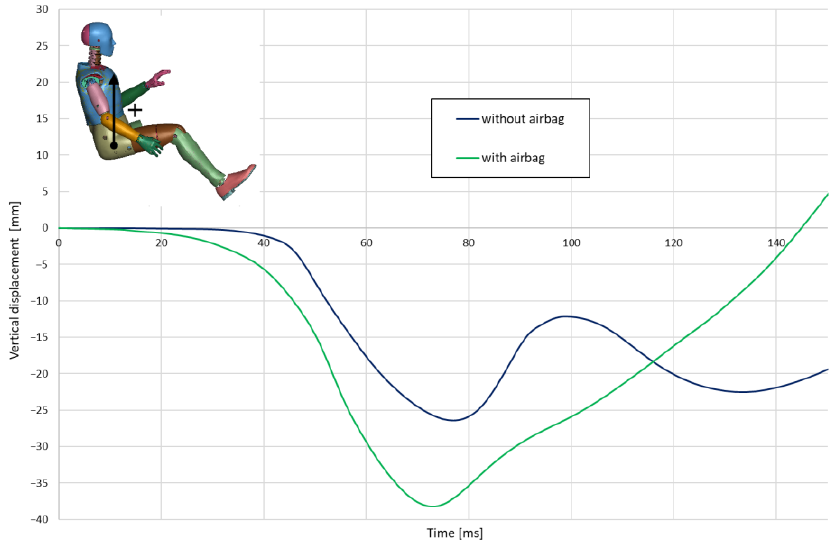
Figure 7. Vertical displacement of H-point.